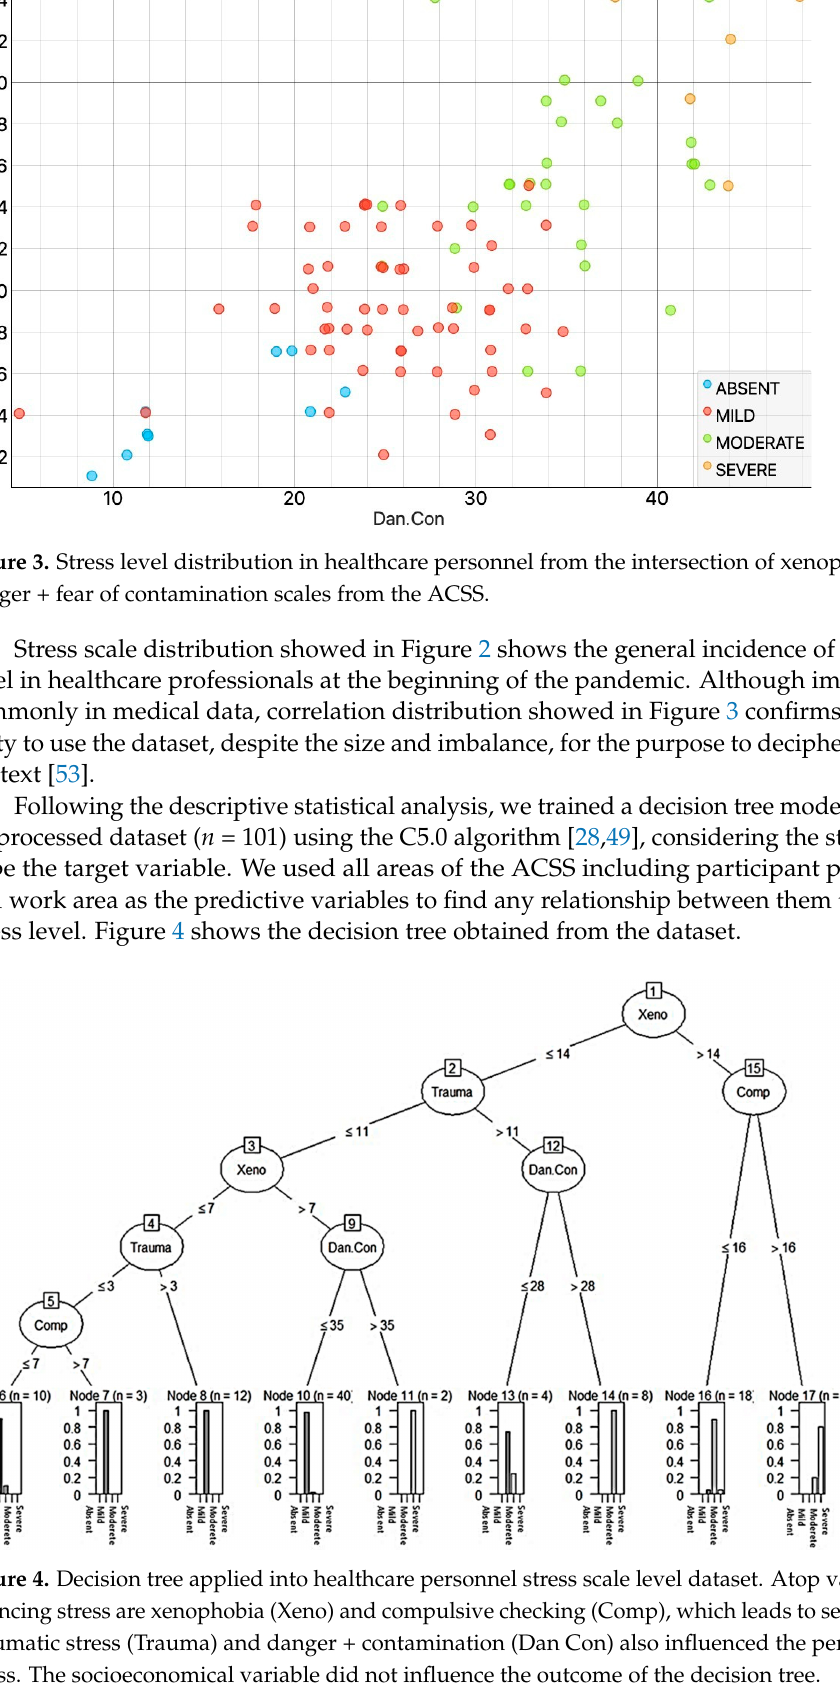
Figure 4. Decision tree applied into healthcare personnel stress scale level dataset. Atop variables influencing stress are xenophobia (Xeno) and compulsive checking (Comp), which leads to severe stress. Traumatic stress (Trauma) and danger + contamination (Dan Con) also influenced the perception of stress. The socioeconomical variable did not influence the outcome of the decision tree. To analyze model performance, a sensitivity and specificity calculation were carried out. For these, three different scenarios were considered based on the stress classification outcome from the dataset, dividing entries into healthy and disease groups. Calculation was completed with the figures from the confusion matrix. Results are shown in Table 5. Table 5. Decision tree sensitivity and specificity calculation from stress scales dataset.